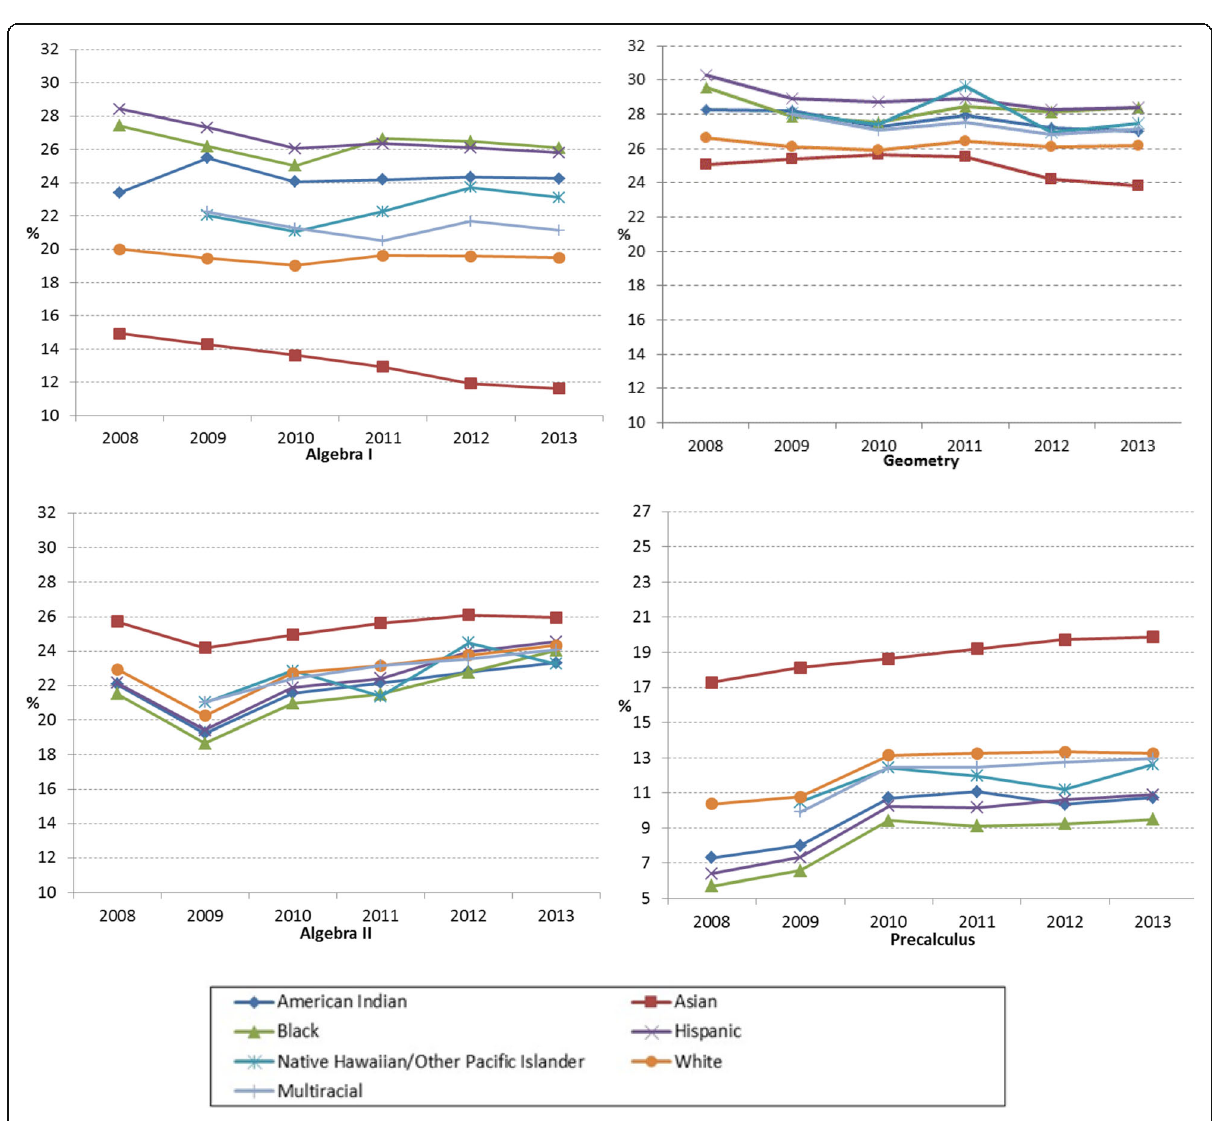
Fig. 10 Required and selective mathematics course enrollment rates in percentage of total number of students in each racial/ethnic group from 2008 to 2013 Table 10 Six-year average enrollment rates and gain/loss of enrollment by race/ethnicity in required and selective mathematics courses Algebra I Geometry Algebra